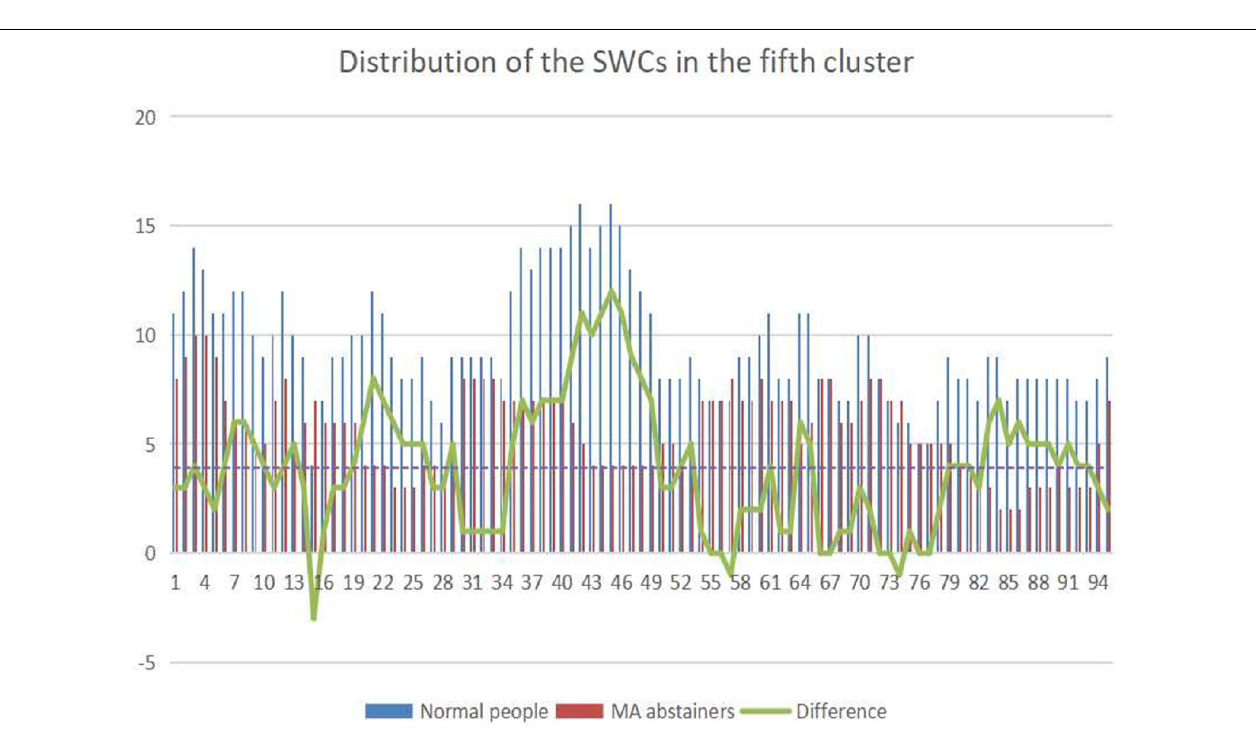
FIGURE 5 | The picture shows the distribution of the sliding windows gathered in the fifth state of normal people and MA abstainers. The abscissa represents the label of the sliding windows, and the ordinate represents the number of sliding windows. The blue column represents the total number of normal people classified into a certain category, and the red one is MA abstainers. The green broken line indicates the difference in the total number of sliding windows.